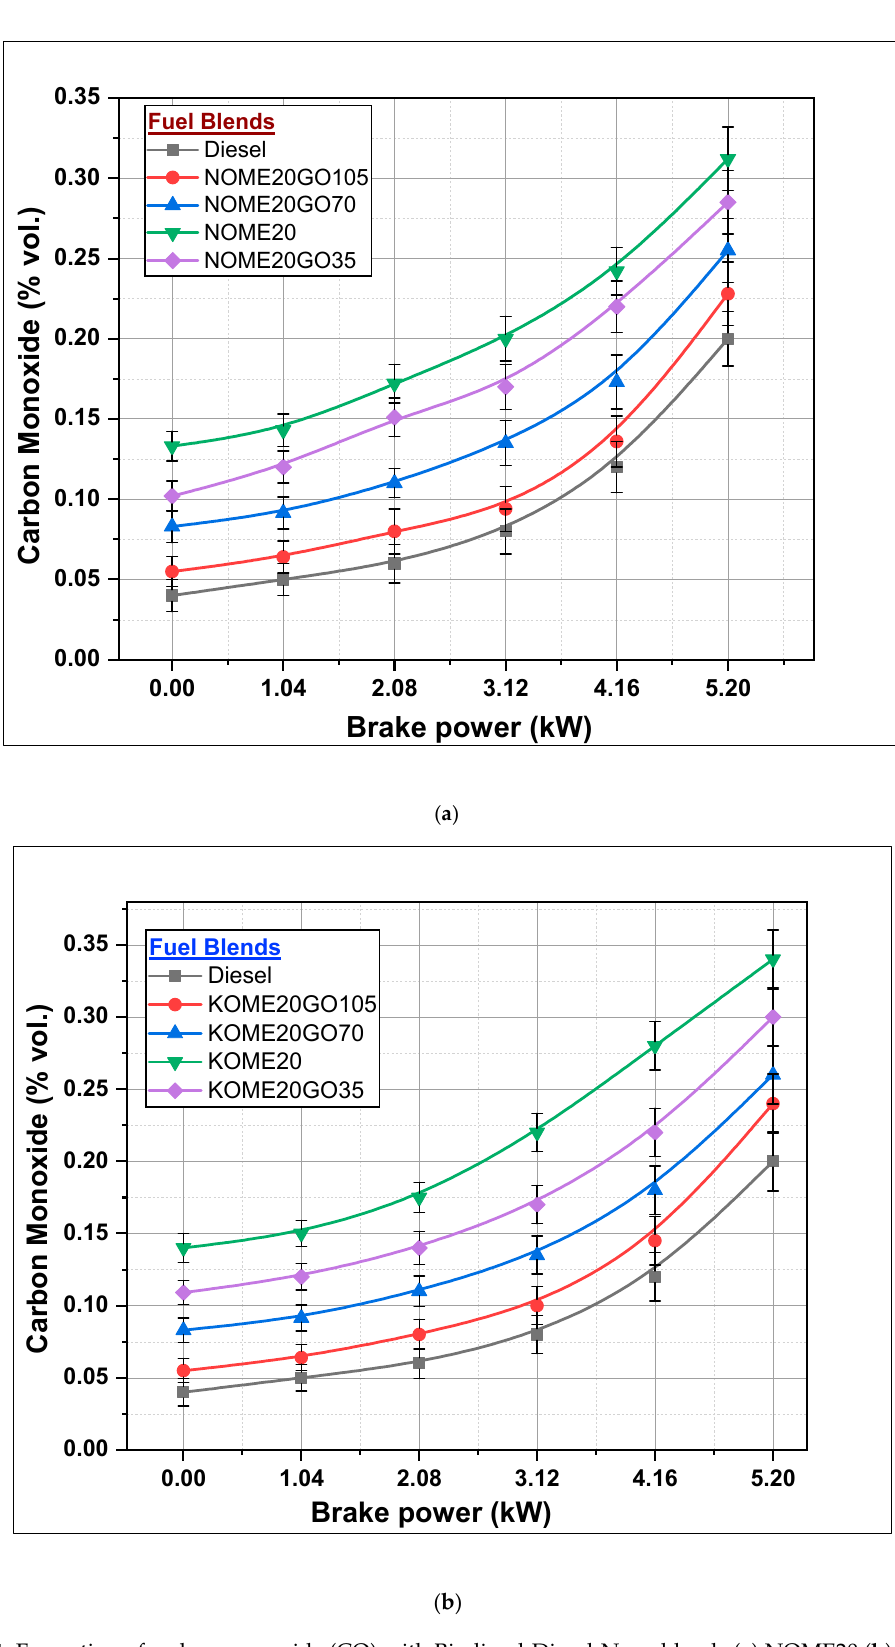
Figure 14. formation of carbon monoxide (CO) with Biodiesel-Diesel-Nano blends ( a ) NOME20 ( b ) KOME20.